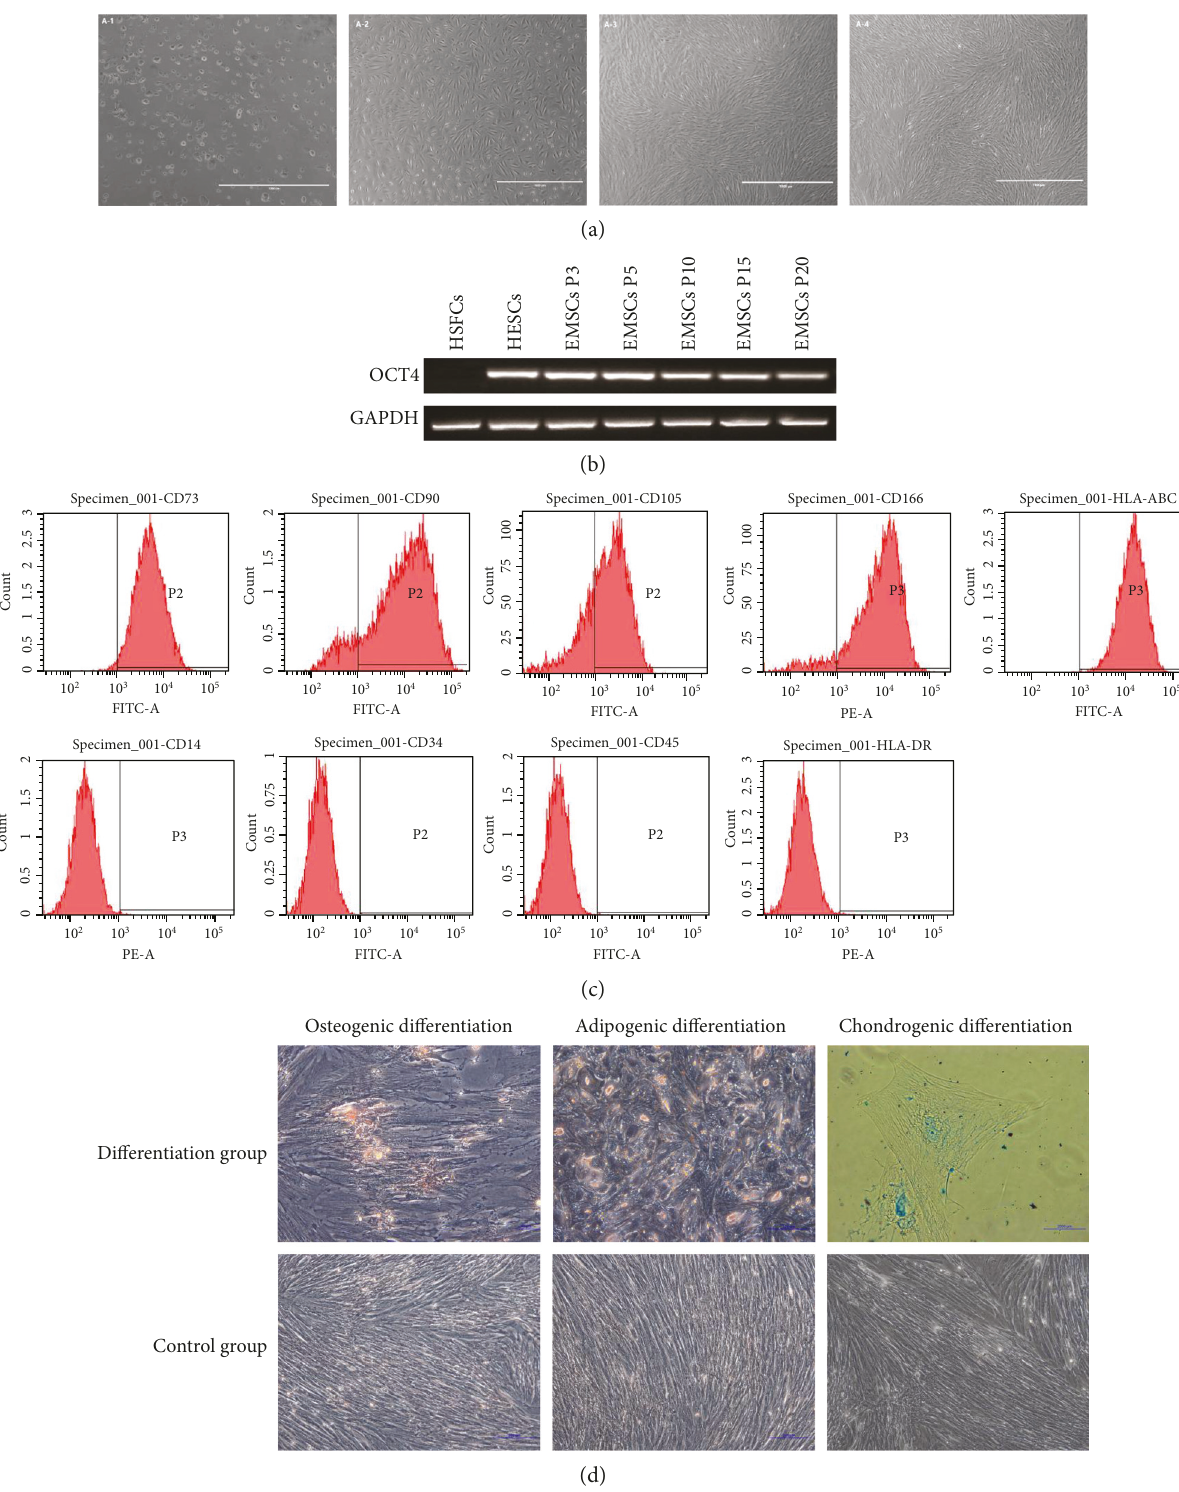
Figure 1: Isolation, cultivation, and identi fi cation of EMSCs. (a) (A-1) Nonadherent cells; (A-2) P1 cells; (A-3) P3 cells; (A-4) P5 cells. Scale bar =1000 μ m. (b) Stem cell-speci fi c marker OCT4 expression in P3, P5, P10, P15, and P20 EMSCs. OCT4 was positively expressed in EMSCs, and the OCT4 expression shown a gradually decreasing trend with increasing passage number. (c) Immunophenotypes of EMSCs. The fl ow cytometry analysis results showed that the EMSCs positively expressed CD73, CD90, CD105, and CD166 but negatively expressed CD14, CD34, and CD45. The results also showed that the EMSCs expressed HLA-ABC (MHC I), but not HLA-DR (MHC II). (d) EMSC di ff erentiation in vitro. The staining results of EMSCs after being cultured in di ff erent induction